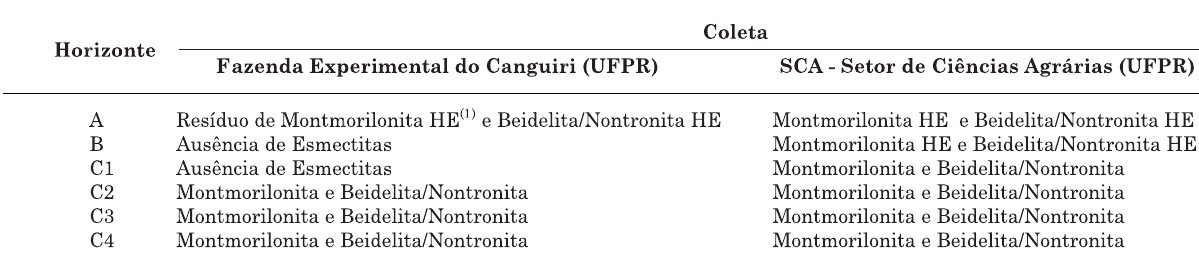
Quadro 4. Identificação das esmectitas dioctaedrais na fração argila dos Cambissolos da Região Metropolitana de